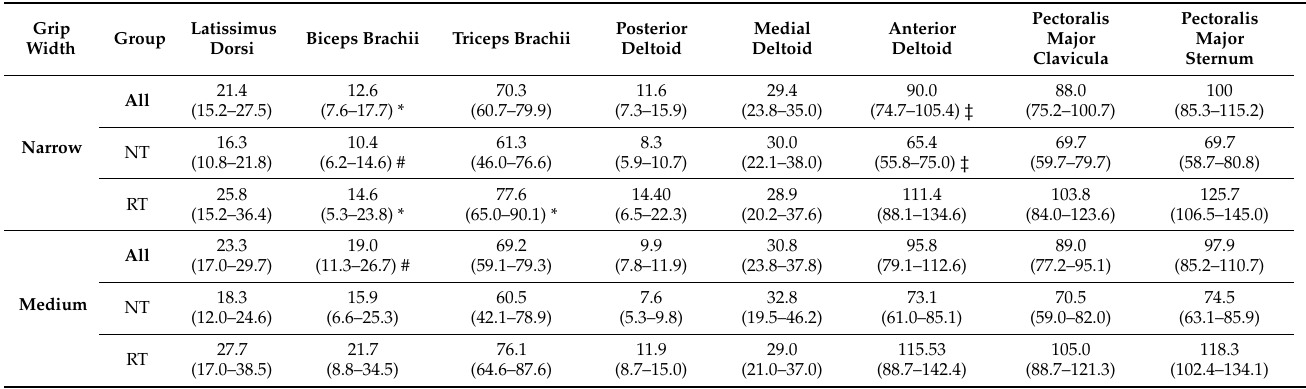
Table 2. Normalized EMG activity (i.e., % of MVIC) from the three grip widths narrow, medium, and wide (mean ± 95%